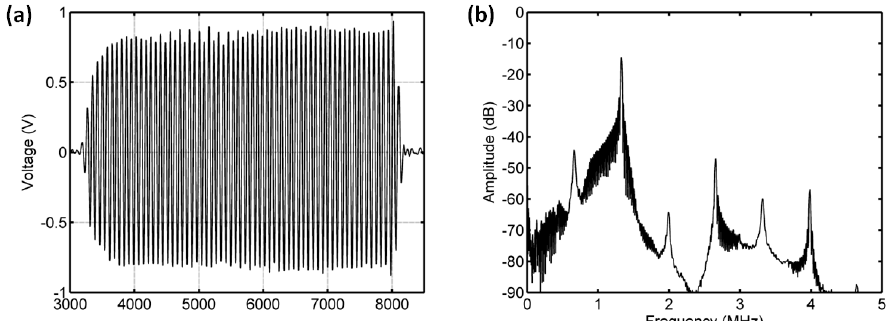
Figure 17. The measured scattering signals from microbubbles and the averaged power spectrum of 50 received signals. ( a ) A single received signal, ( b ) the averaged power spectrum. The driving frequency was 1.33 MHz, the acoustic pressure was 350 kPa, and the overpressure was 8 mmHg.